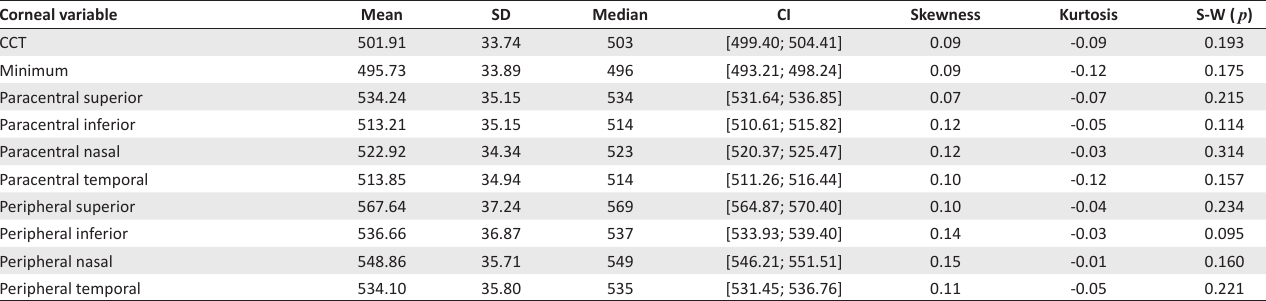
TABLE 1: Distribution of corneal thickness measurements ( µ m) in the different zones of the right eye for the entire sample ( N = 700). Corneal variable Mean SD Median CI Skewness